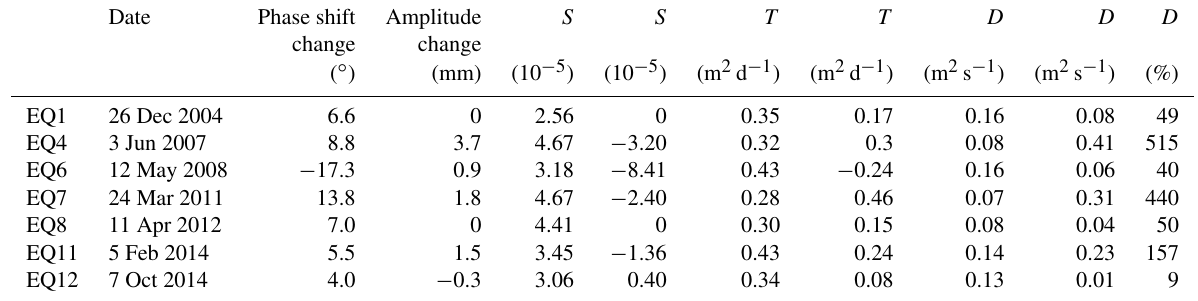
Table 2. Aquifer parameters estimated using tidal analyses before and after selected earthquakes in Dazhai well, western Yunnan, China. Date Phase shift